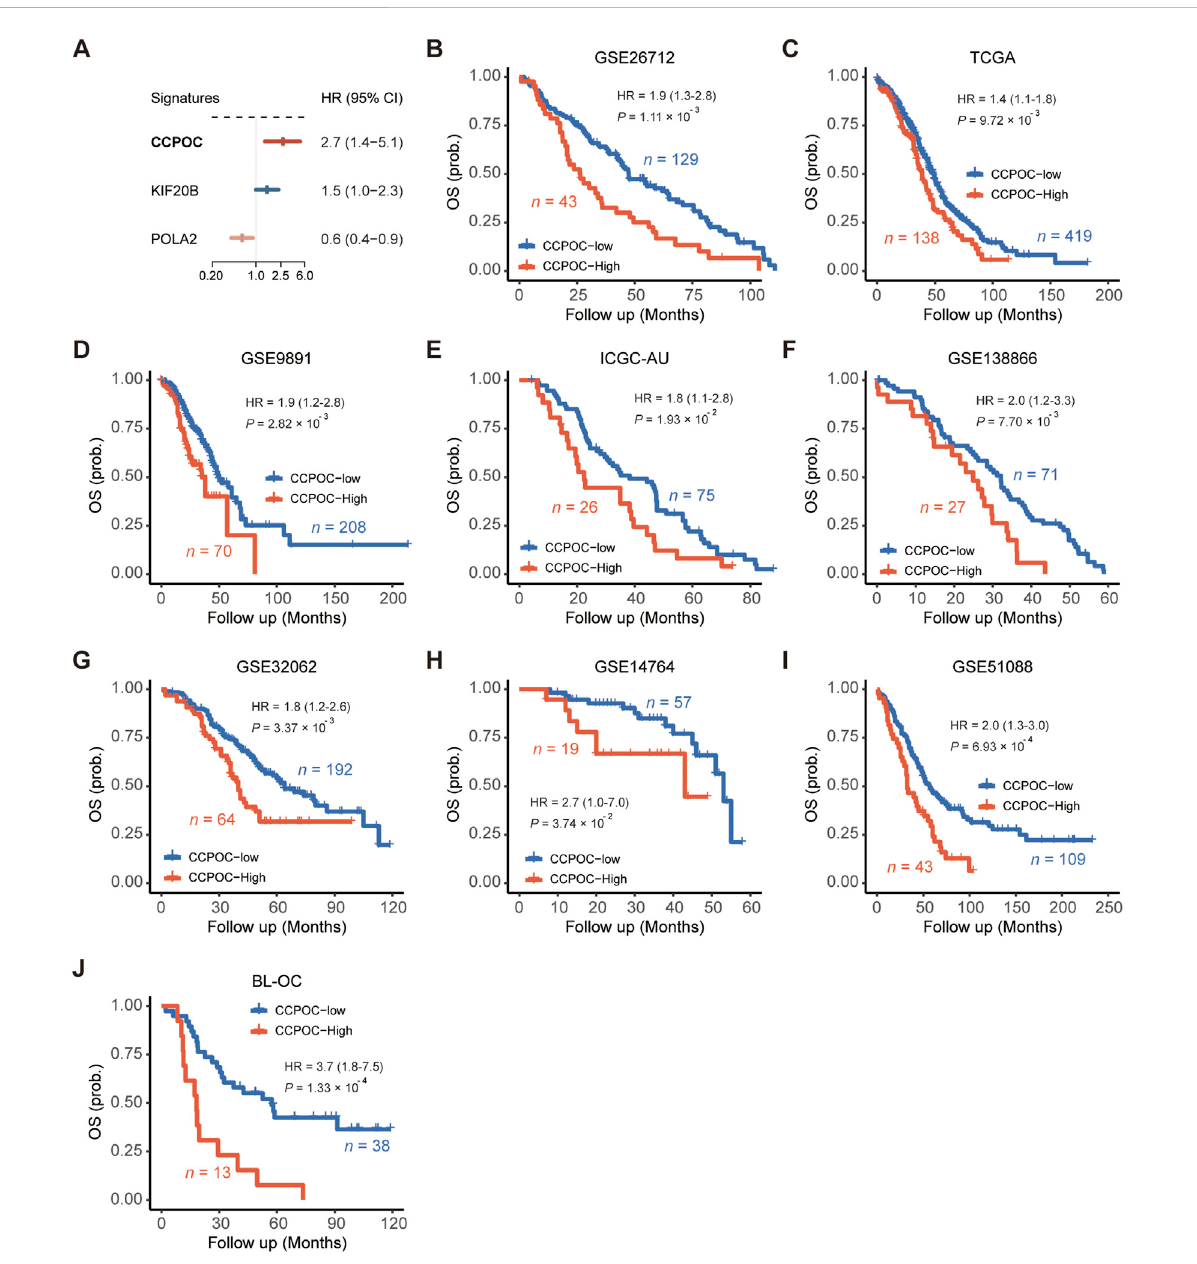
FIGURE 3 Assessment of the prognostic value of the CCPOC. (A) Comparison of prognostic ef fi ciencies between the CCPOC and its individual constituents. (B) Kaplan – MeiersurvivalanalysisshowingthattheCCPOC-highgrouphadanunfavorableOSinthetrainingcohort(GSE26712).Inthe seven public validation cohorts (C – I) , the CCPOC-high group stably showed a signi fi cantly poor prognosis for OS. (J) Evaluation of the prognostic value of CCPOC in the BL-OC